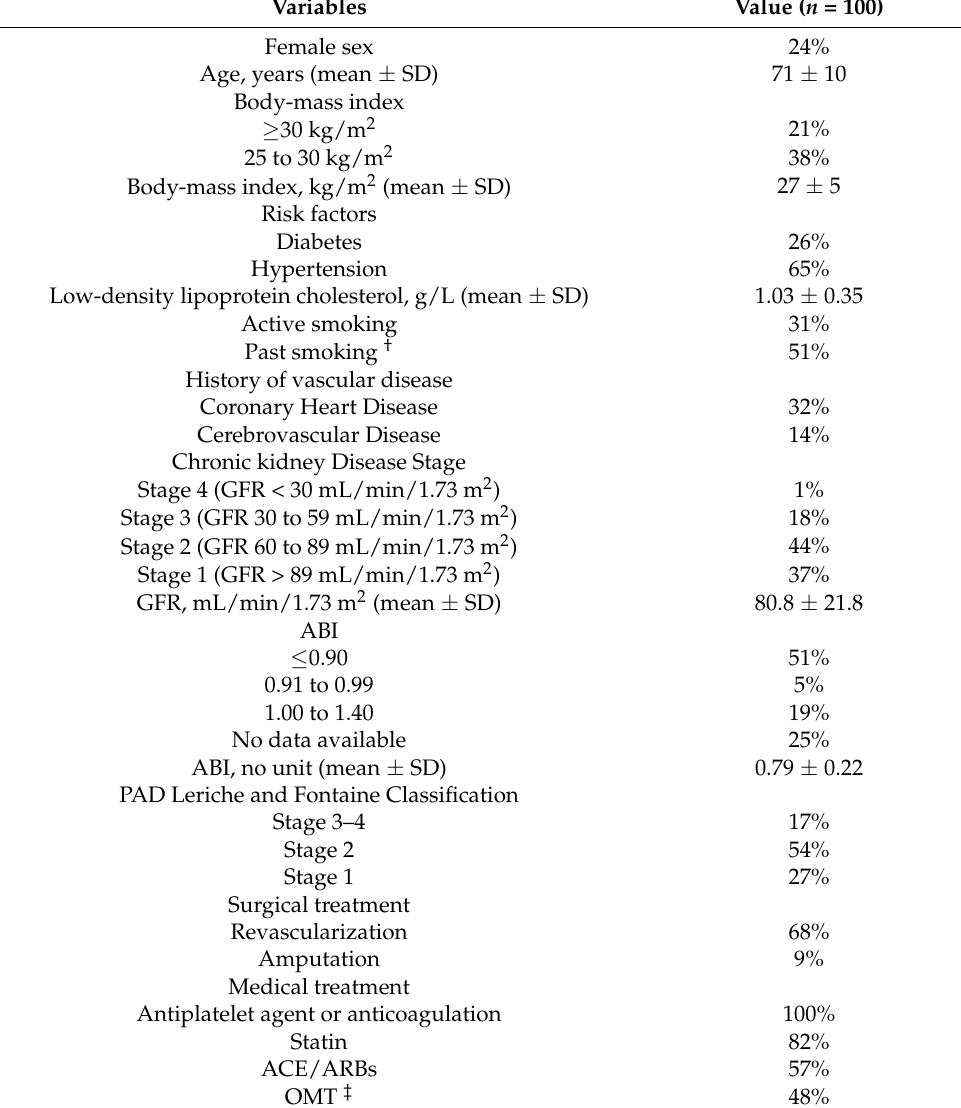
Table 1. Baseline characteristics of the 100 patients with lower extremity peripheral artery